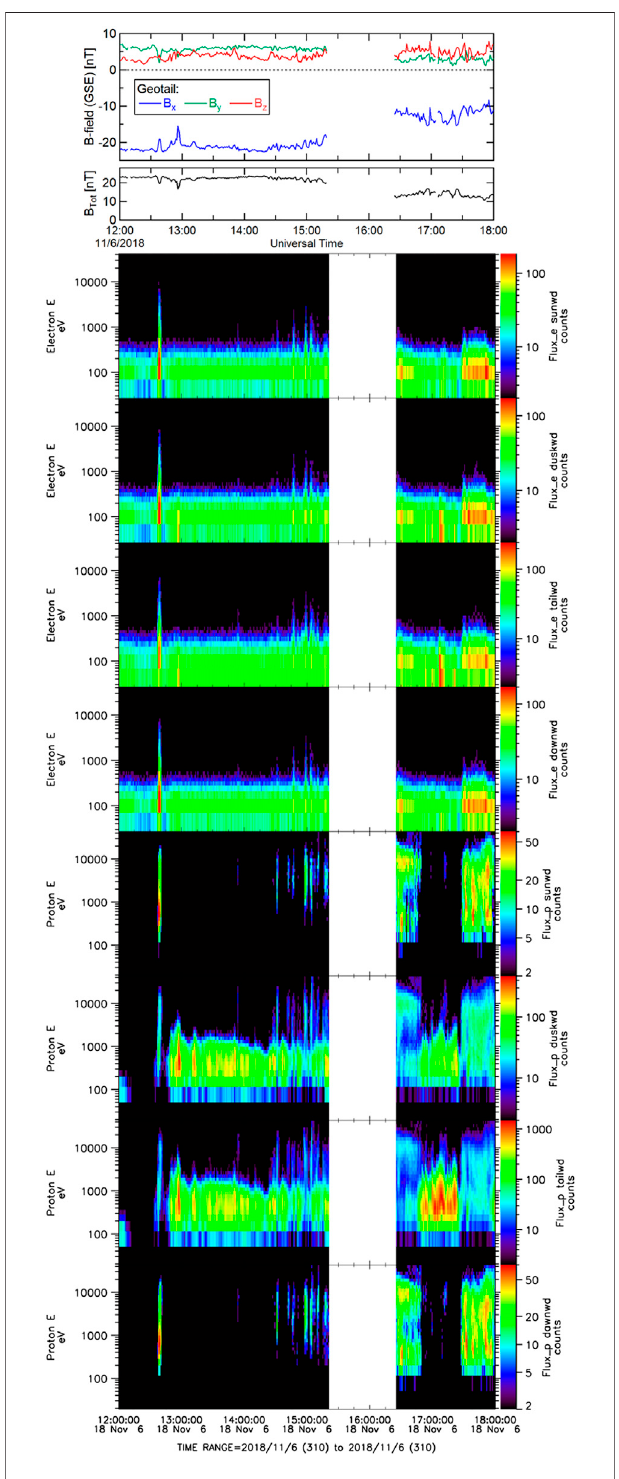
FIGURE 8 | Geotail observations of the magnetic fi eld, electron energy fl ux spectrograms, and proton energy fl ux spectrograms observed in four directions. Color scale of fl ux min/max values are auto-scaled within each